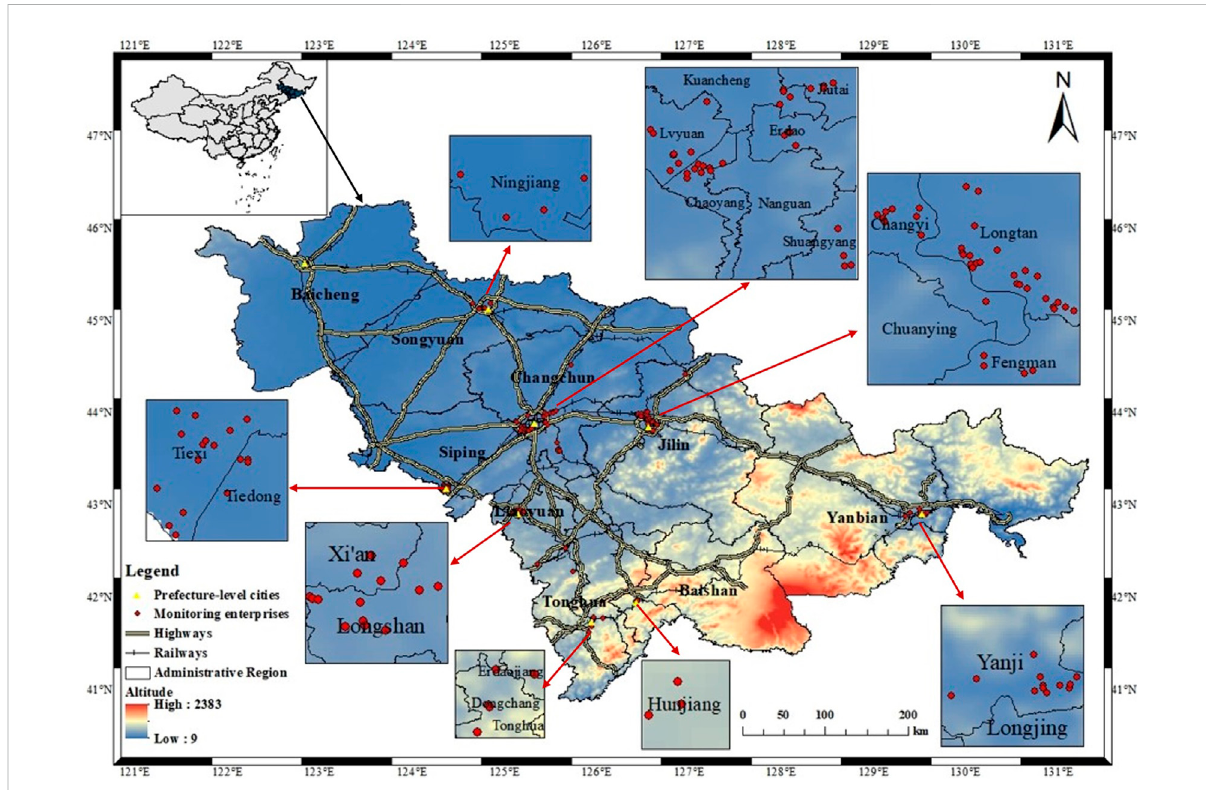
FIGURE 1 Topography and administration of Jilin Province. The spatial distribution of monitoring enterprises in each prefecture-level city. Yellow solid triangles represent prefecture-level cities; red solid circles represent monitoring enterprises; black solid lines depict the boundaries of city/county/ district; the gradient color represents the altitude of Jilin province. Red solid lines point to the spatial distribution of monitoring enterprises in each prefecture-level